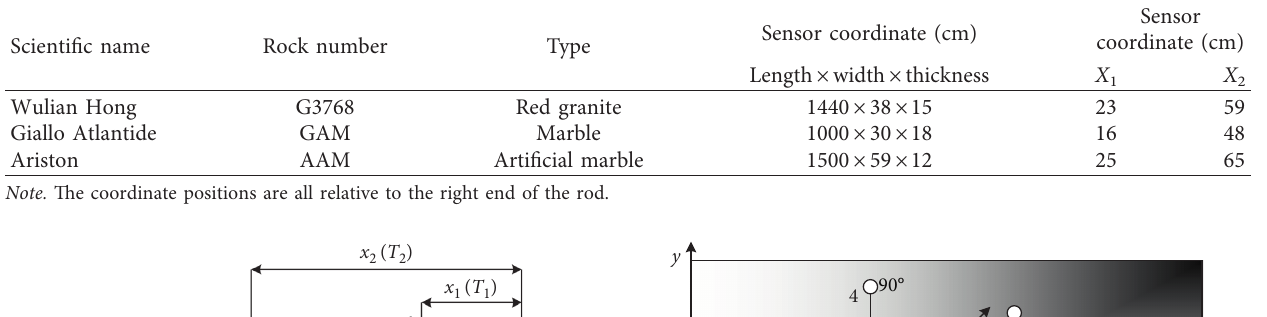
Table 1: The coordinates of sensors on the rod-shaped rock samples.